Question: Express in one sentence what the figure is showing.
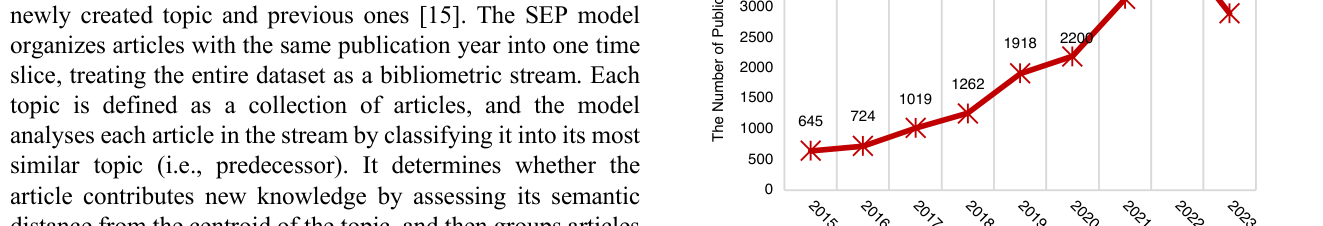
Answer: Publication Trends of Responsible AI-related Articles since 2015.